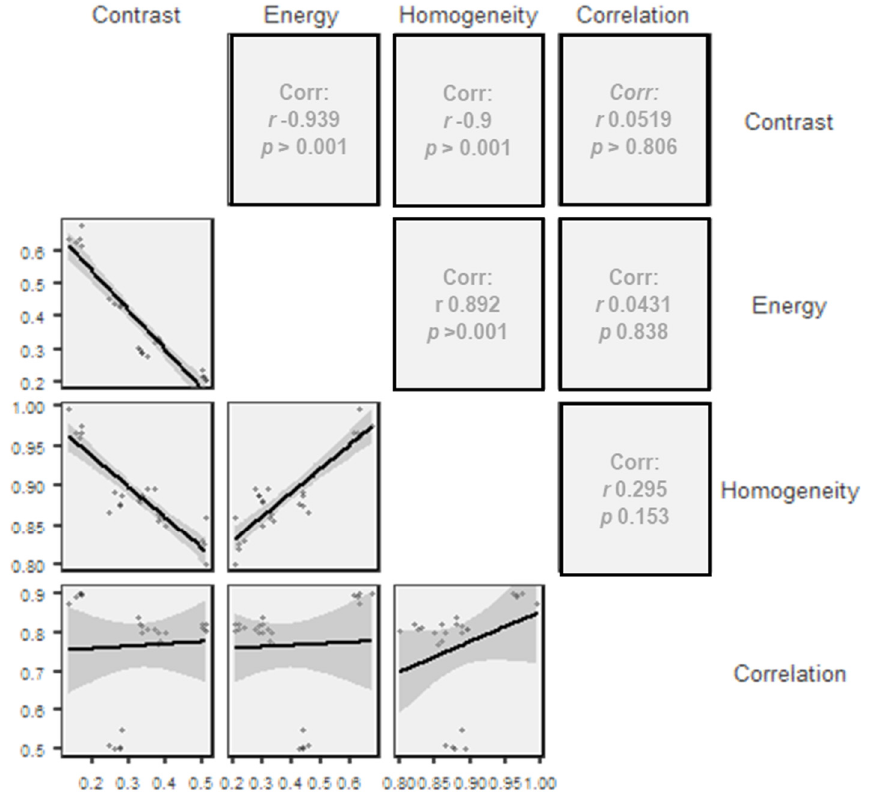
Figure 13. Correlation matrix (Pearson) for the different characteristics analyzed.